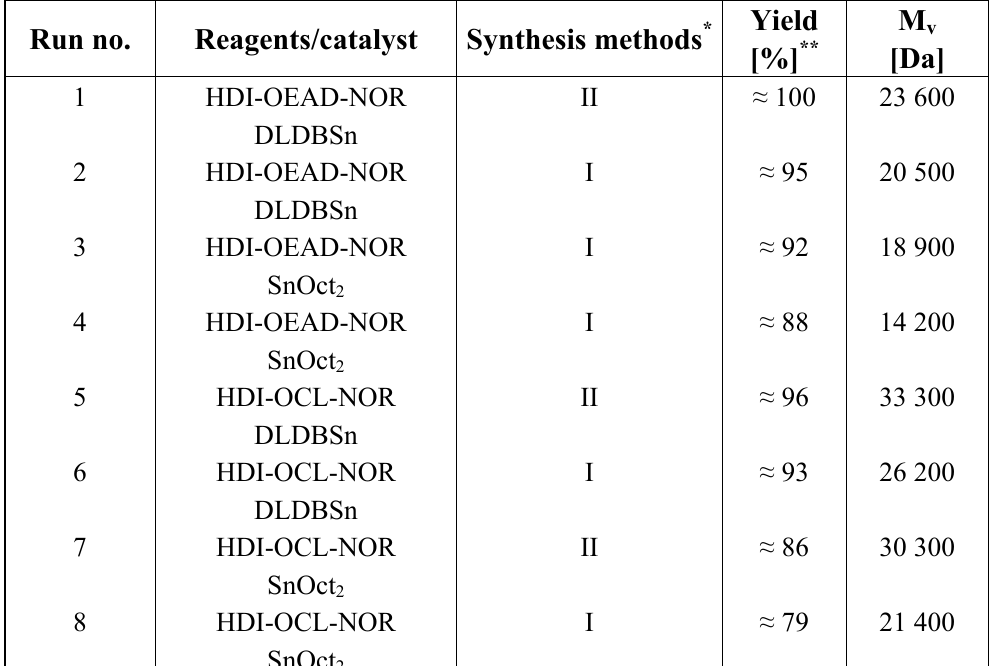
Table 2. Polyurethane conjugates of